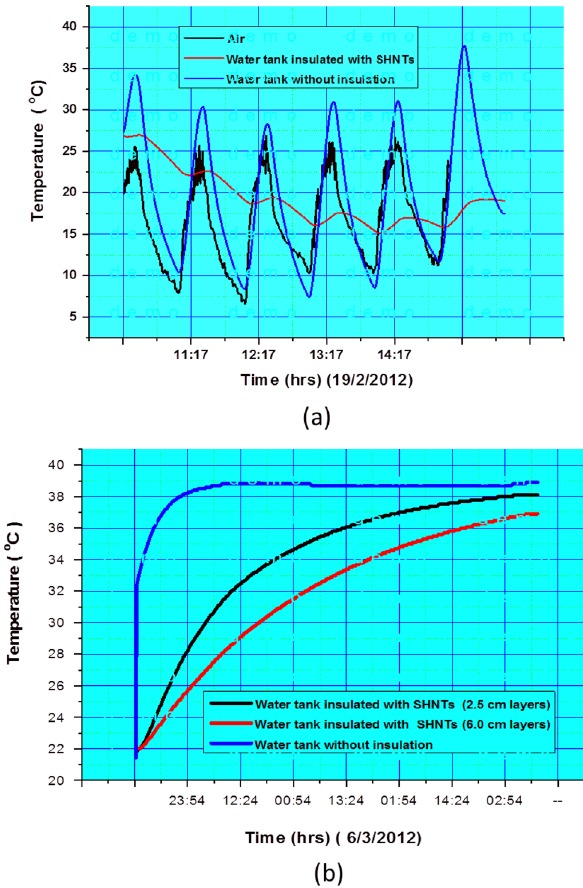
Figure 6. ( a ) Relationship between the time and temperature changes of water in the tank insulated with SHNTs in comparison to the open-air temperature and water in the tank without insulation under natural temperature changes in the field. ( b ) Relationship between the time and temperature changes of water in the tank insulated with SHNTs in comparison to water in the tank without insulation at a constant temperature of (40 °C) in the control room of the